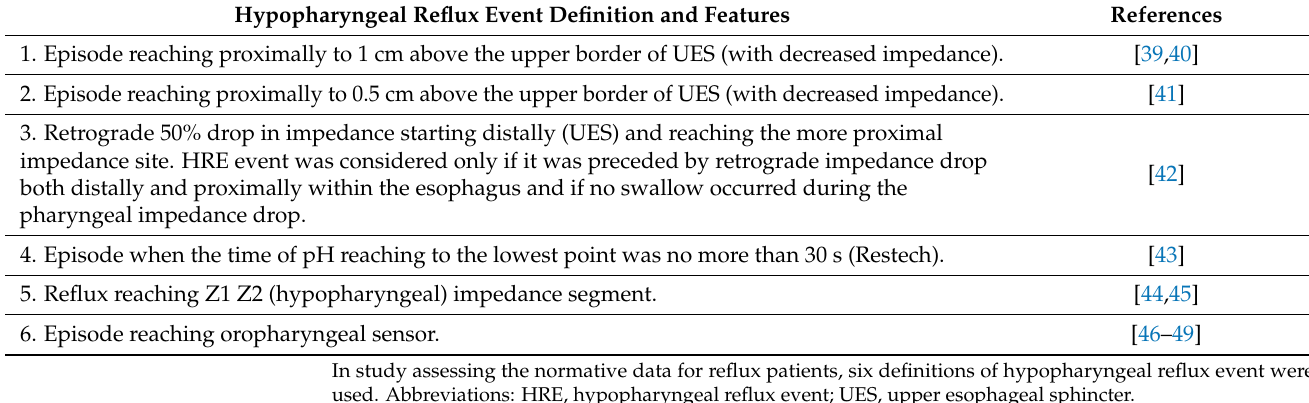
Table 1. Definitions of hypopharyngeal reflux events according to studies. Hypopharyngeal Reflux Event Definition and Features